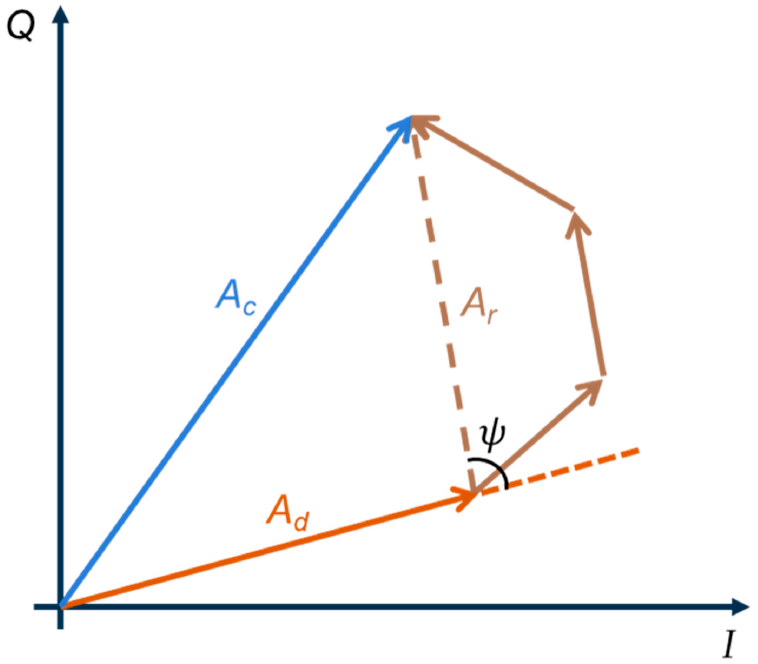
Figure 1. Phasor diagram between the in-phase (I) and quadrature (Q) channels. where 𝐴 (cid:3030) denotes the amplitude of the composite signal recorded by the receiver; 𝐴 (cid:3031) and 𝐴 (cid:3045) denote the amplitudes of the direct and reflected signals, respectively; and 𝜓 de- notes the phase difference between the two signals.